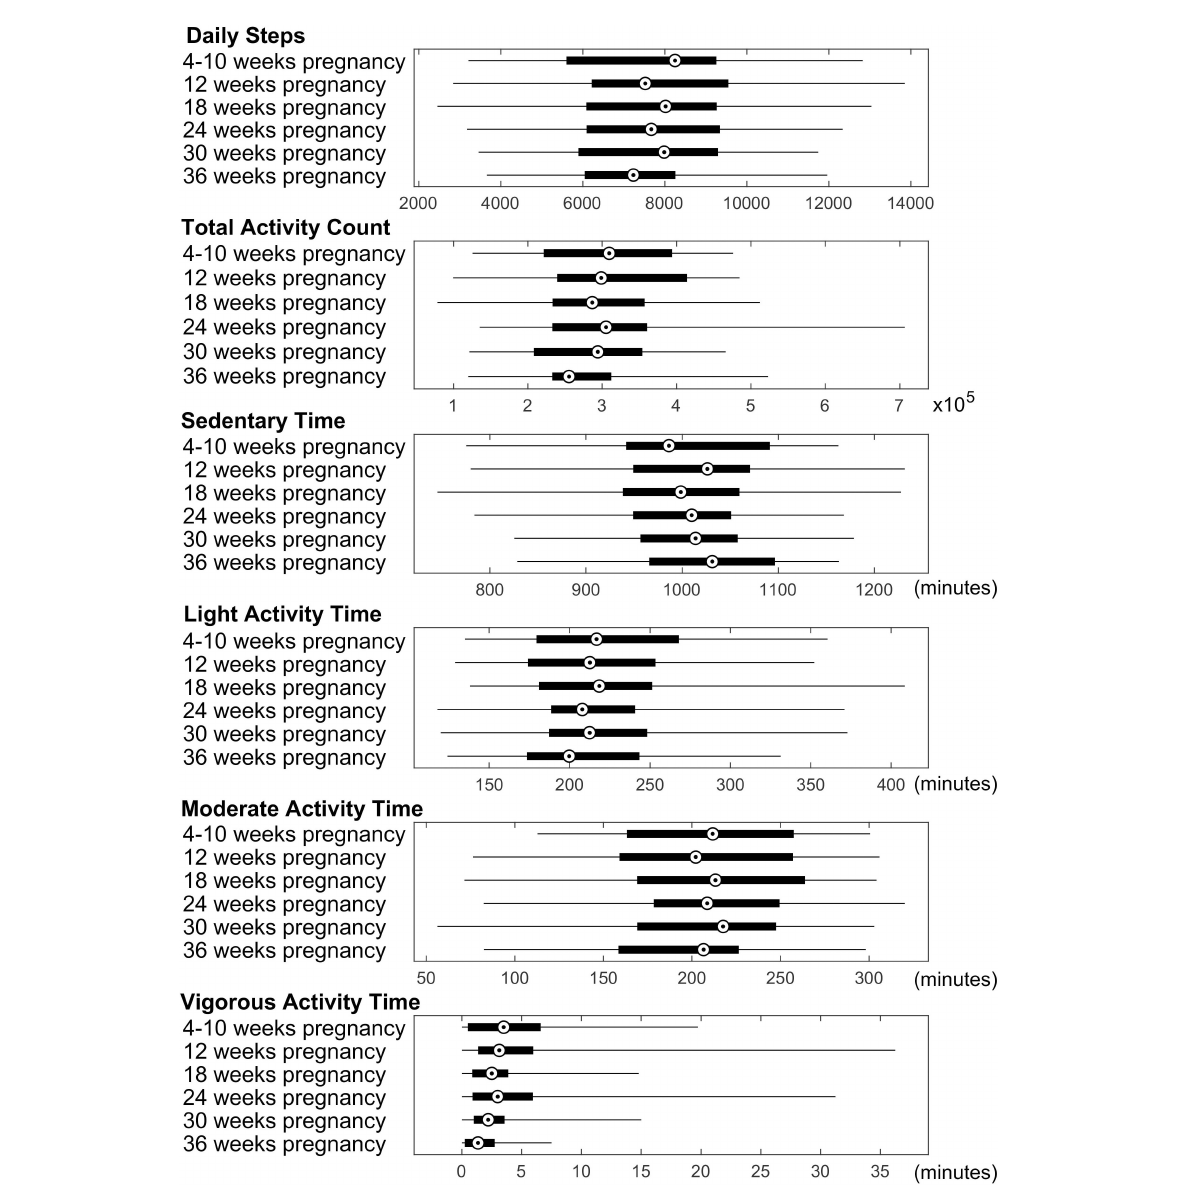
FIGURE1 Summary of physical activity data for the pregnant women. Average daily steps, daily total activity count, and daily time spent in sedentary/light/moderate/vigorous activity modes throughout the pregnancy are presented. Median value, 25th and 75th percentiles, as well as range are shown for each